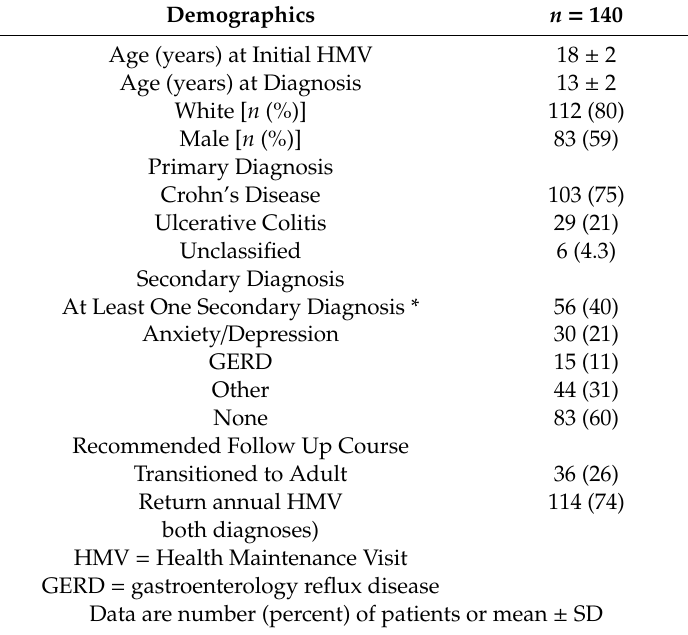
Table 1. Clinical Characteristics of Patients at First